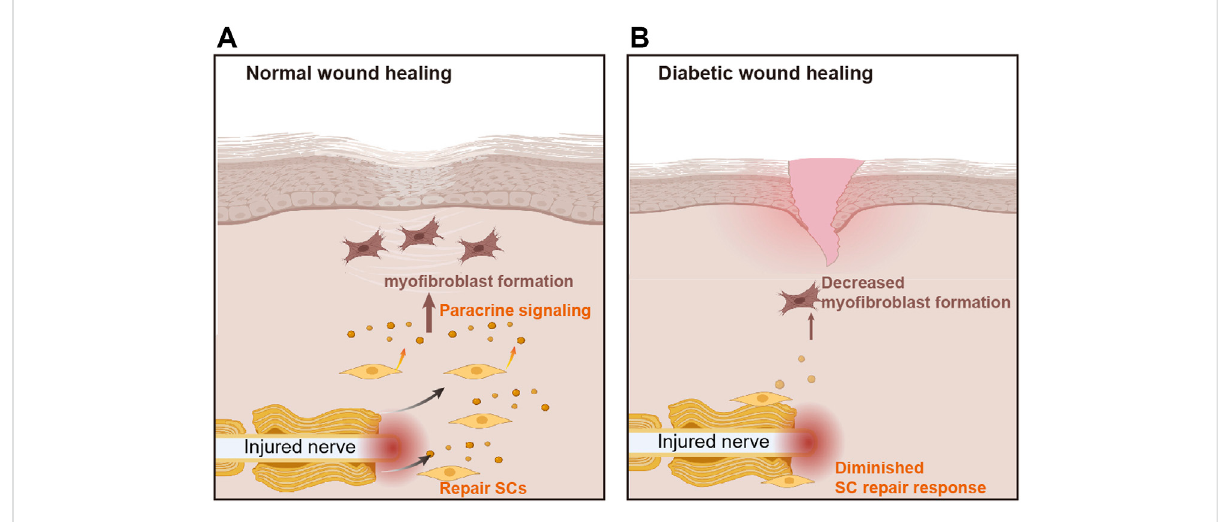
FIGURE 11 The role of Schwann cells in diabetic wound healing. (A) In normal wounds, nerve injury stimulates the aggregation of Schwann cells (SCs), which release paracrine signals to stimulate myo fi broblast formation and promote wound healing. (B) The repair response of SCs is attenuated in diabetic wounds, resulting in reduced myo fi broblast formation and delayed wound